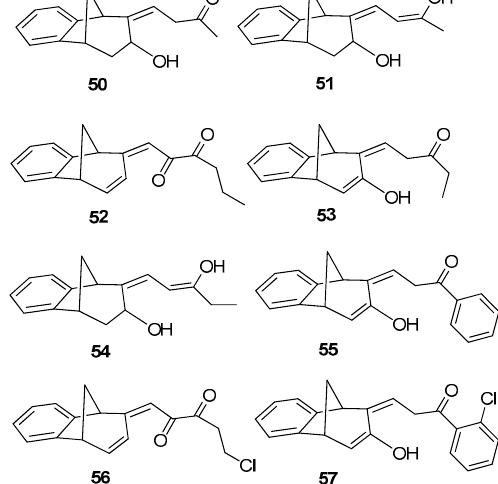
Figure 13. Isolated products of acylation reaction.